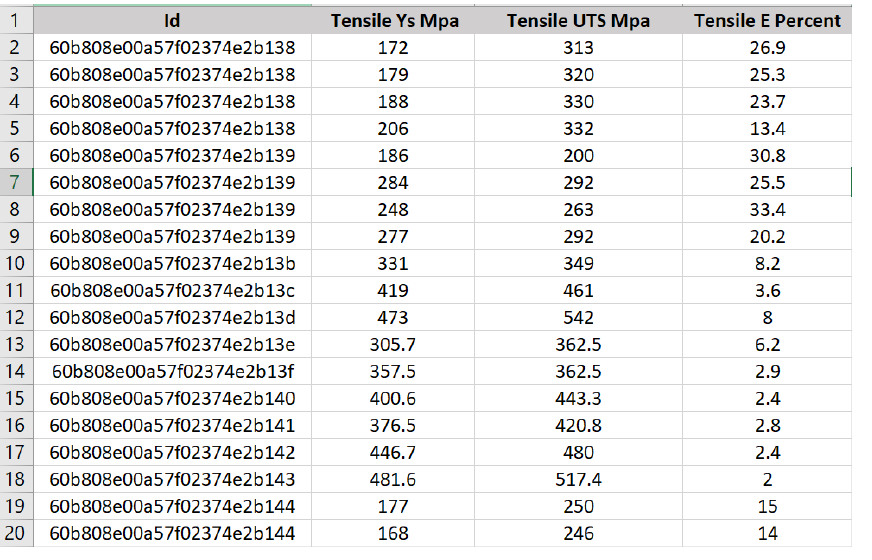
Figure 5. Numerical Tensile properties retrieved from database using query from Pseudocode 2.